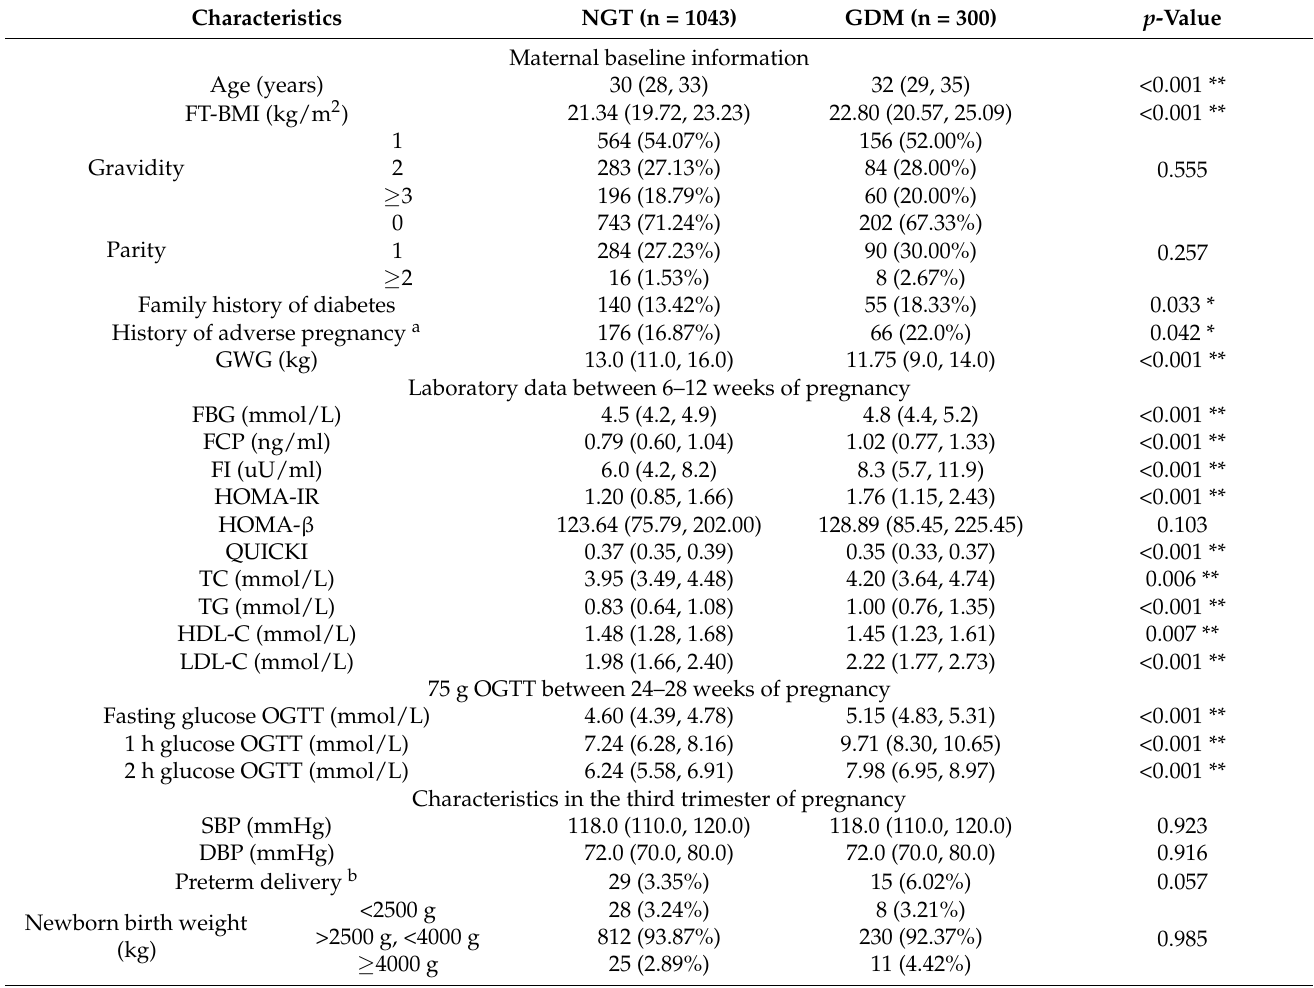
Table 1. Baseline characteristics and pregnancy outcomes of pregnant